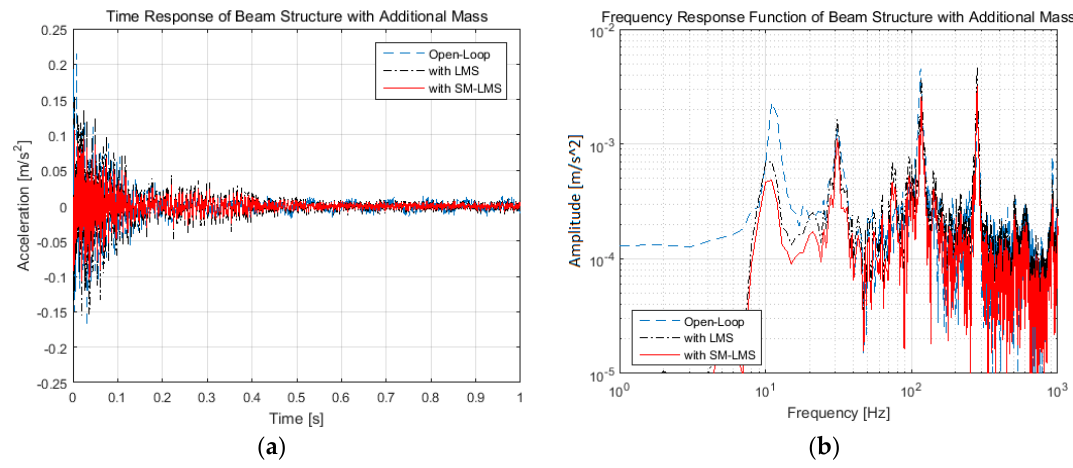
Figure 20. Experimental result for the modified structure: ( a ) time domain; and ( b ) frequency domain.